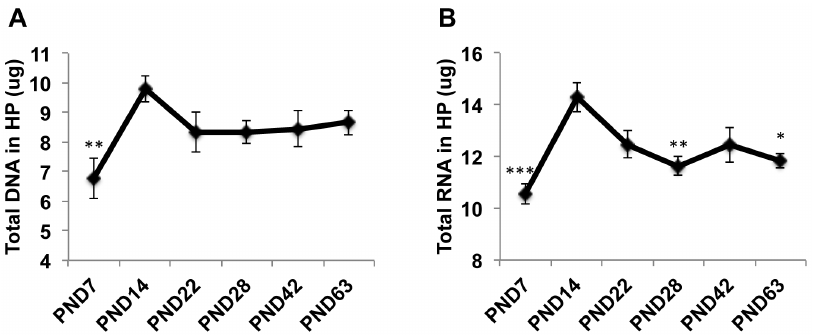
Fig. 1. The developing hippocampus undergoes accelerate growth during the second week of life. Total levels of DNA (A) and RNA (B) extracted from the hippocampus at different developmental ages. N 5 9 male mice per age. Error bars represent mean ¡ SEM. *p , 0.05, **p , 0.01, ***p , 0.0005, One-way ANOVA followed by Tukey-post hoc analysis when compared to PND14.